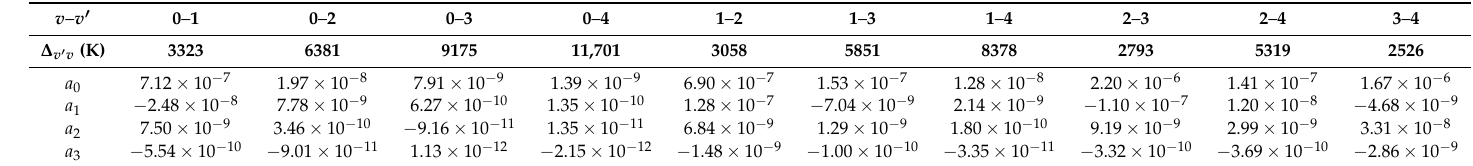
Table 4. Same as Table 3 for 4 HeD + .